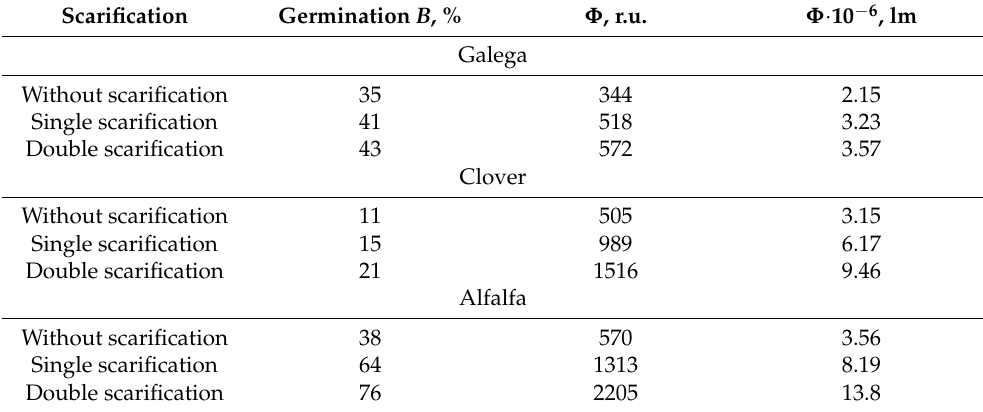
Table 1. Germination and photoluminescence flux of forage plant seeds with different scarifications.